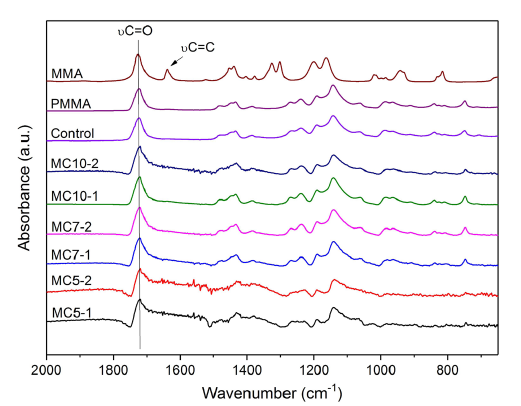
Figure 1. FTIR spectra of MMA, PMMA, Control, MC5, MC7 and MC10.